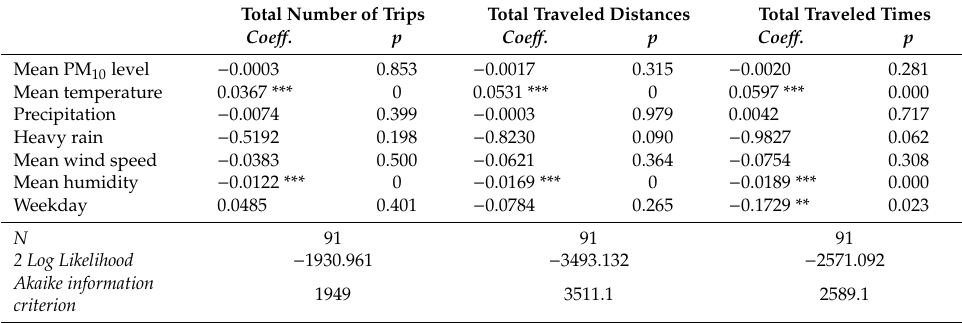
Table 9. Estimation results for bike sharing use using PM 10 level data in fall.